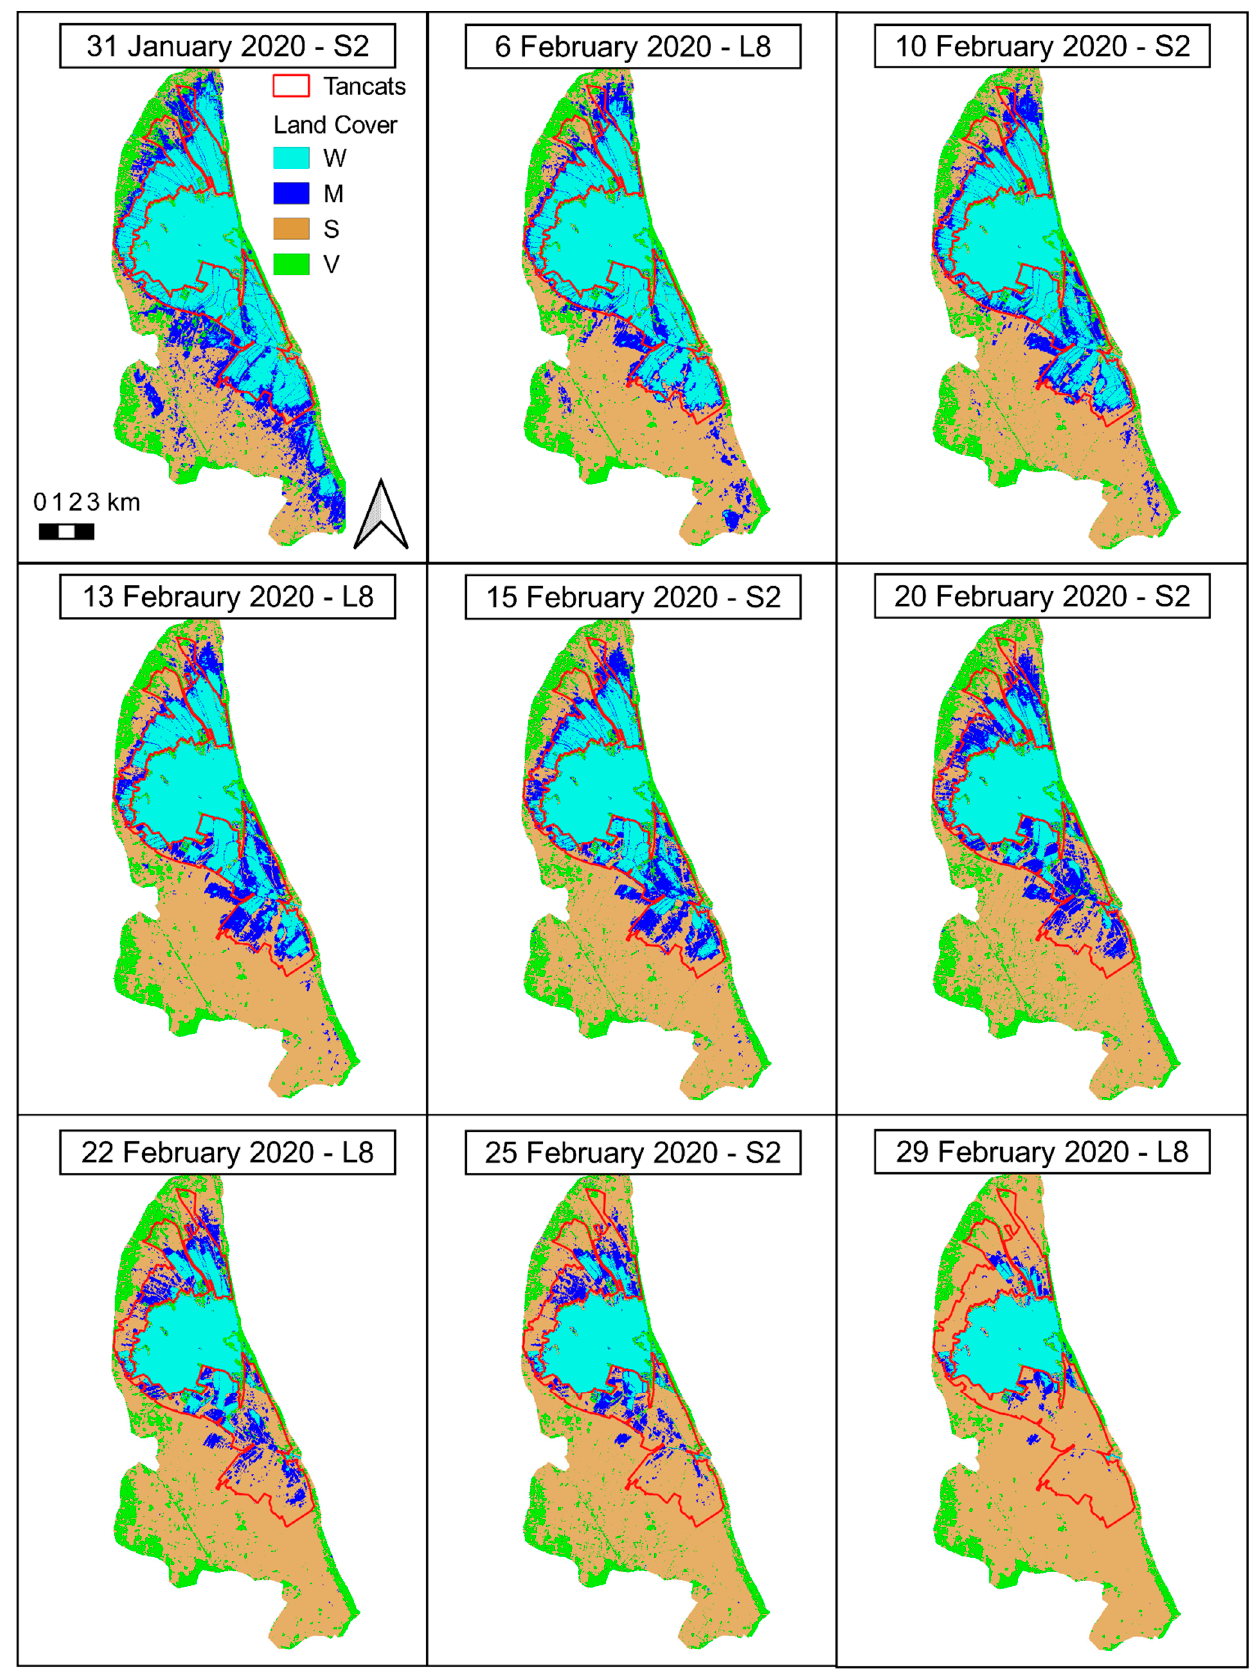
Figure 11. Maps of land cover classes in February 2020 obtained by L8 and S2. The continuous line is the boundary of Tancats area.